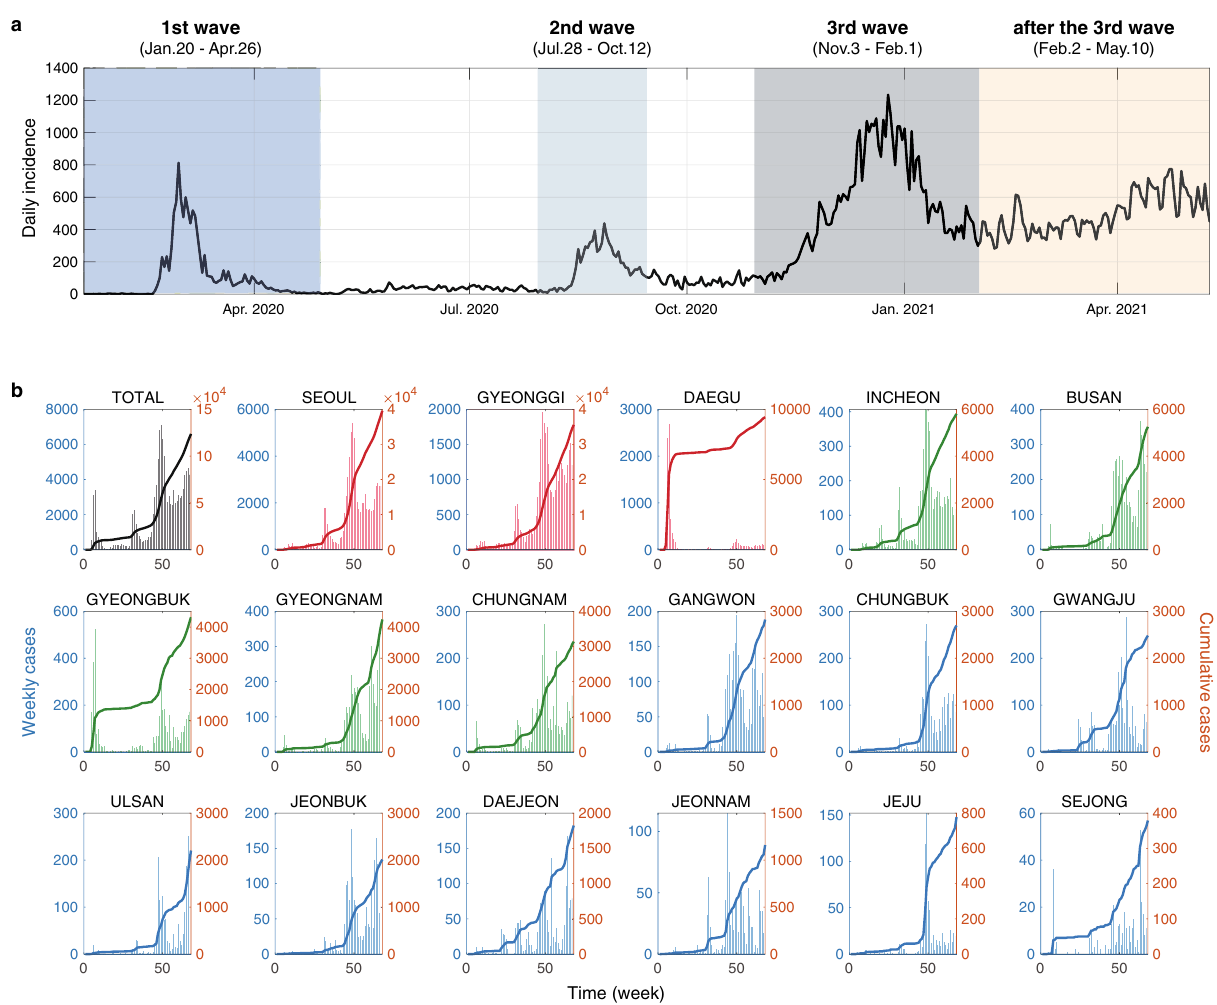
Figure 2. Time series of COVID-19 outbreak in South Korea. ( a ) Daily incidence of COVID-19 in South Korea. South Korea went through three big waves, after the third wave, the incidence has been maintained with no significant increase or decrease. The four windows of main interest were colored and given as; (1) the first wave (January 20, 2020–April 26, 2020); (2) the second wave (July 28, 2020–October 12, 2020); (3) the third wave (November 3, 2020–February 1, 2021); and (4) after the third wave (February 2, 2021–May 10, 2021). ( b ) Weekly incidence and cumulative cases in 17 regions, plotted as the bars and as a curve, respectively. The three highest cumulative cases, the next five highest cases, and the rest cases are marked with red, green, and blue,